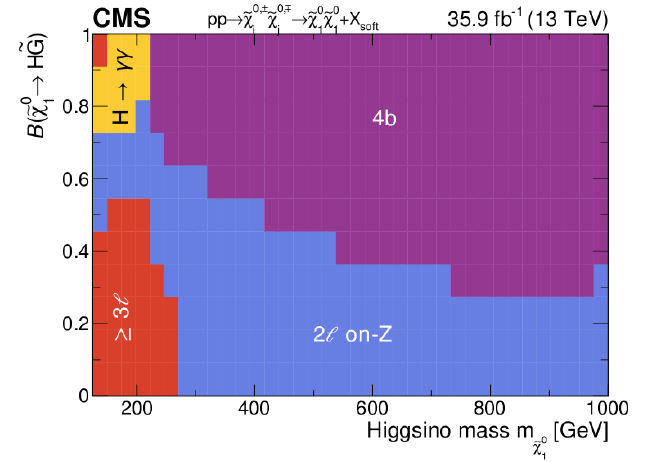
Figure 13 . The analysis with the best expected exclusion limit at each point in the plane of m and B